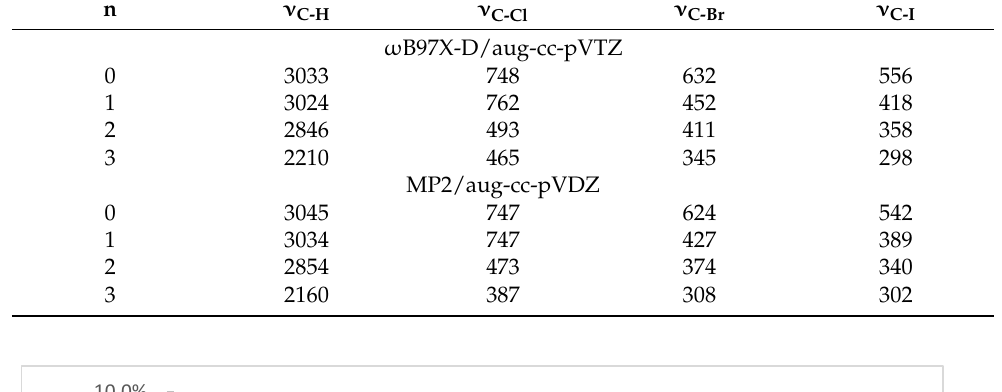
Table 5. Stretching frequencies, ν C-X (cm − 1 ), for CH 3 − n (CN) n X ··· NMe 3 (X = H, Cl, Br, or I; n = 0–3).